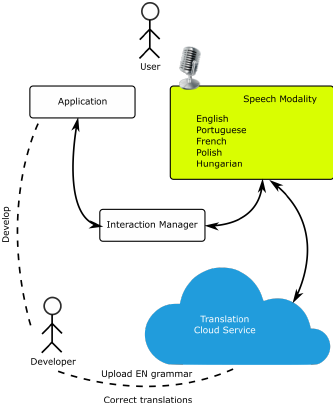
Figure 4. Overall illustration of multilingual speech interaction design. The developer uploads a grammar in English and a translation service generates grammars for other languages. Speech recognition (at client or server side) uses Microsoft Speech Platform, that offers recognition for several